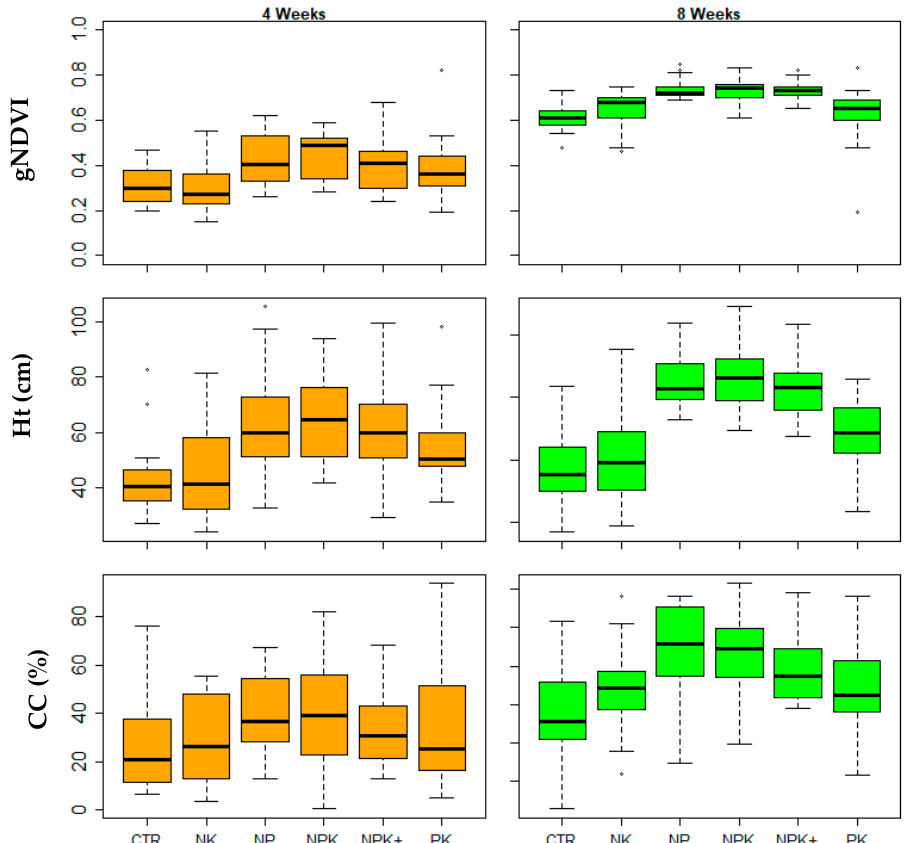
Figure 3. Ground measured normalized difference vegetation index (NDVI), plant height (Ht), and percent canopy cover (CC) of maize in smallholder farms imposed with different nutrient treatment conditions under multilocational and widely distributed nutrient omission trials (NOTs). At 4 weeks after sewing (WAS) (orange boxplots), the nutrient treatment effect was not evident, but significantly higher effects of NP, NPK, and NPK+ were observed at 8WAS (green box plots). CTR = Control, N = Nitrogen, P = Phosphorus, K = Potassium, and + denotes addition of micronutrients. The horizontal line on each boxplots shows mean value, and the whiskers indicate the 95% confidence interval.